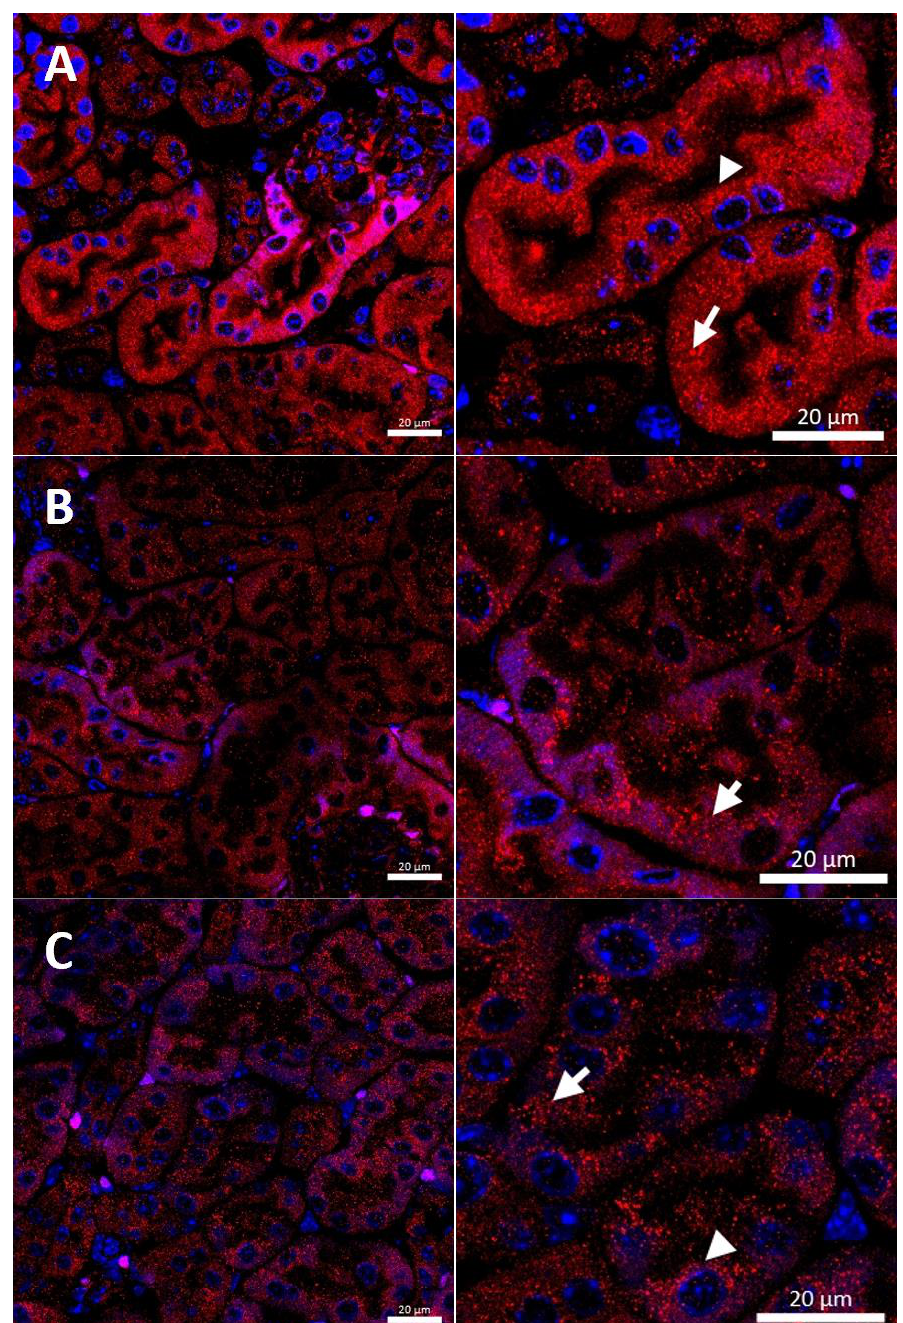
Figure 6. Immunofluorescent staining of CTR1 protein (red channel) analyzed by confocal microscopy in the kidney of the young (45-day-old). Right panels show digital enlargement of CTR1 staining visualized in left panels to reveal details of CTR1 cellular localization. This was performed using the ROI function of the ZEN programme: ( A ) W-t mouse, apical (arrow-head) and cytoplasmic (short arrow) localization (red dots) of CTR1 protein in the epithelial cells of the proximal renal tubules. ( B ) Cupric chloride-administered w-t mouse, cytoplasmic localization of CTR1 protein visible in the form of the red dots (short arrow) in the epithelial cells of the proximal renal tubules. ( C ) Cupric chloride-treated mosaic mutant. Cytoplasmic localization of the CTR1 protein (in the form of the red dots, short arrow) in the epithelial cells of the proximal renal tubules. Nuclei were counterstained with DAPI. Bars correspond to 20 μm.